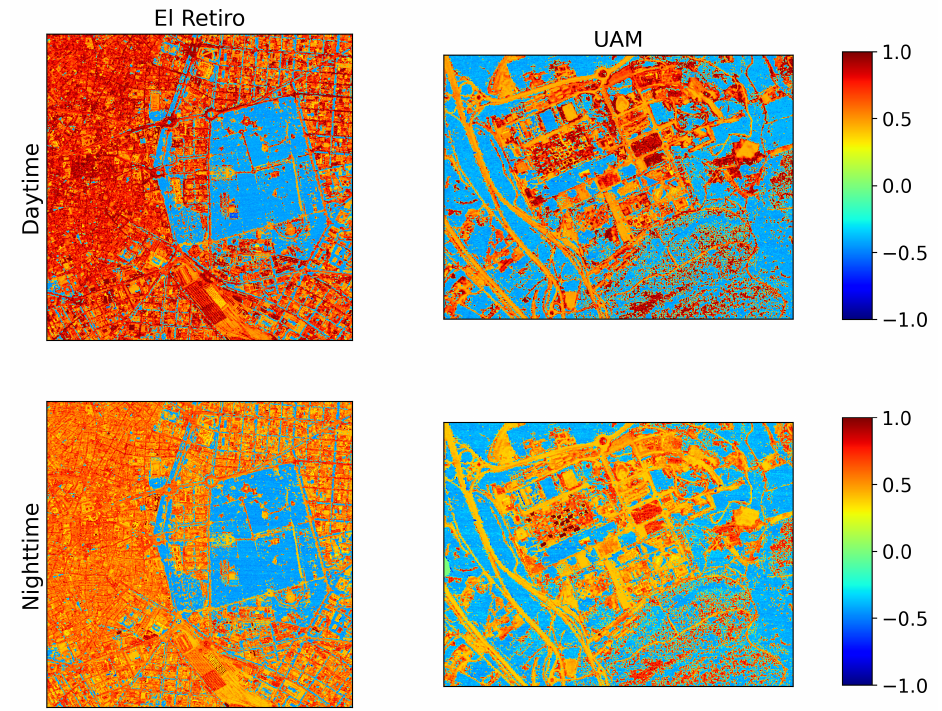
Figure 12. Pixel per pixel difference of the LST in K between the 2MMD-4-band TES and the 1MMD- 4-band TES over the Retiro Park ( left ) and the UAM ( right ) during the daytime ( top ) and nighttime ( bottom